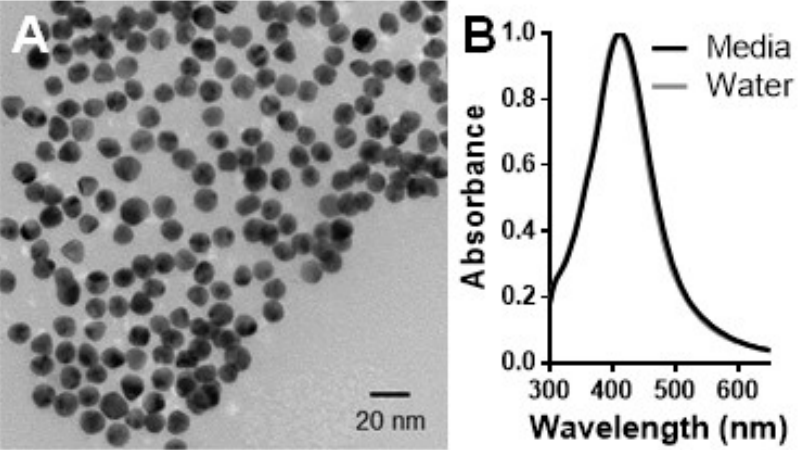
Figure 1. Characterization of the AgNP stock solution. ( A ) A representative TEM image verified the spherical morphology, uniform nature, and primary size of the experimental 10 nm citrate coated AgNPs. ( B ) The spectral signature of the AgNPs was visualized using UV–VIS in both water and complete media at a concentration of 25 µg/mL.